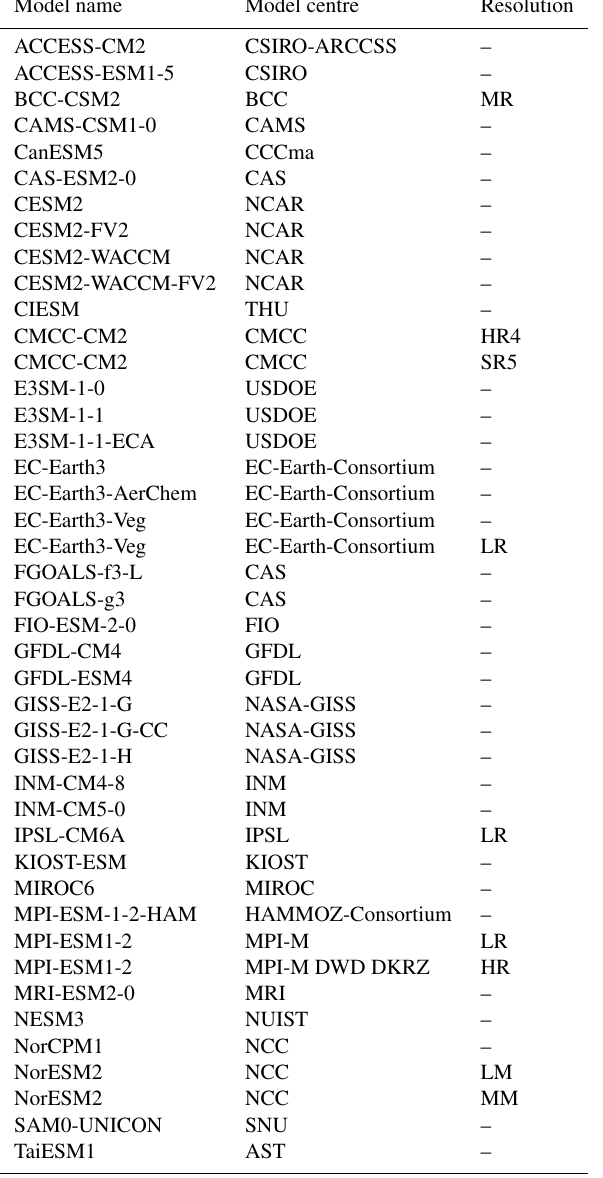
Table A1. List of CMIP6 models used in this